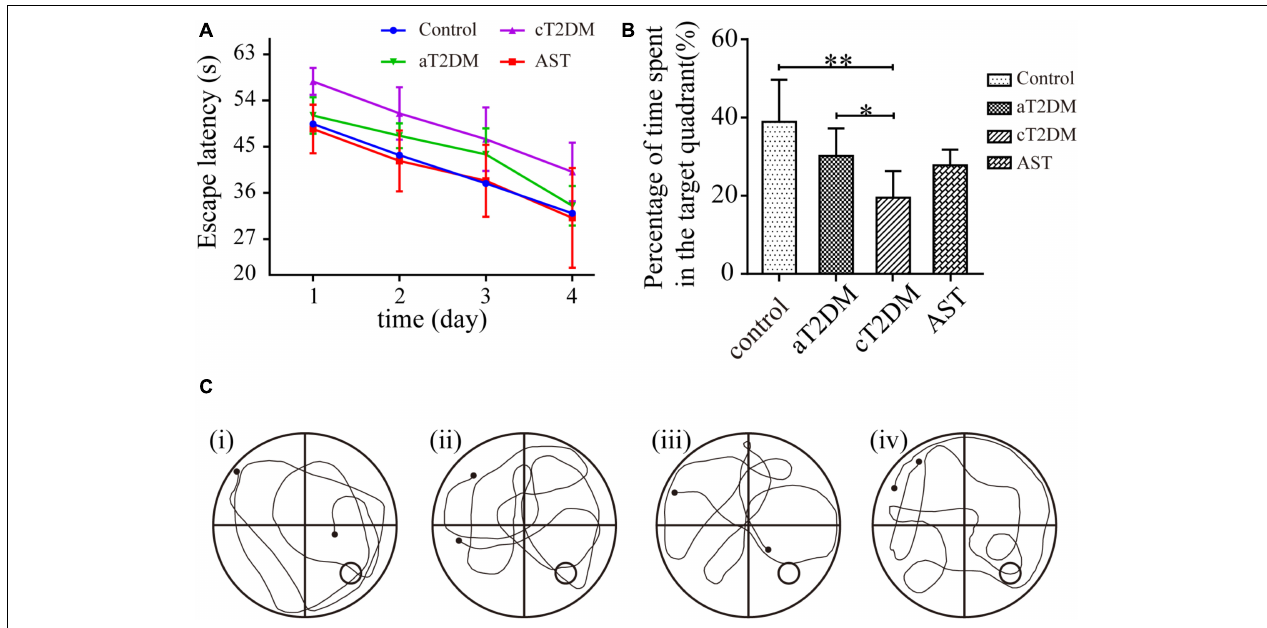
FIGURE 2 | Effect of AST on the spatial learning and memory of each group. This figure exhibits the cognitive function (as measured by the Morris water maze test) of the control, aT2DM, cT2DM, and AST groups. The line chart shows the average escape latency (A) in the place navigation test over 4 consecutive days. In the probe trial, the percentage of time spent in the target quadrant (B) , and the typical swimming traces (C) were recorded. (i) control group; (ii) aT2DM group; (iii) cT2DM group; (iv) AST group. Data are shown as the mean ± SD. ∗ P < 0.05, ∗∗ P < 0.01. aT2DM, acute type 2 diabetes mellitus; cT2DM, chronic type 2 diabetes mellitus; AST,